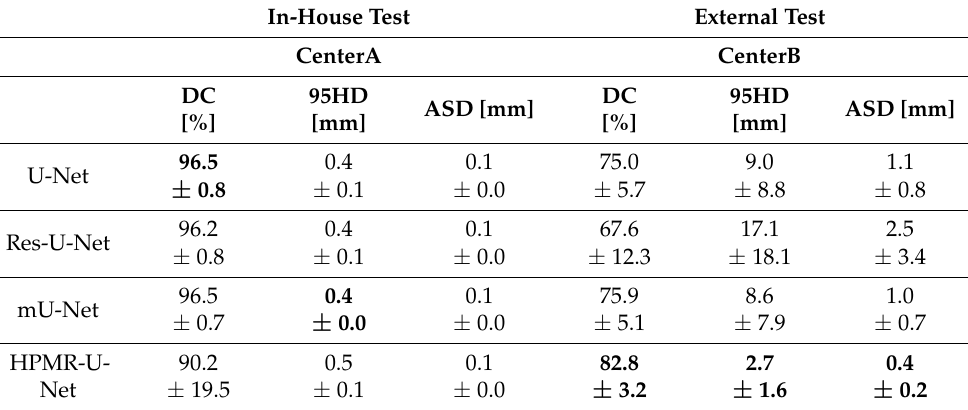
Table 3. Results of in-house and external tests for maxilla segmentation. The best case is bolded.